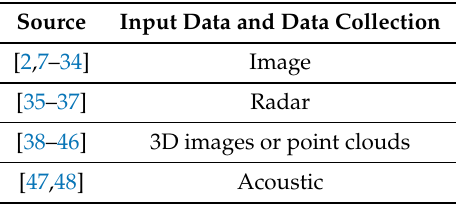
Table 1. Research by input data and data collection.